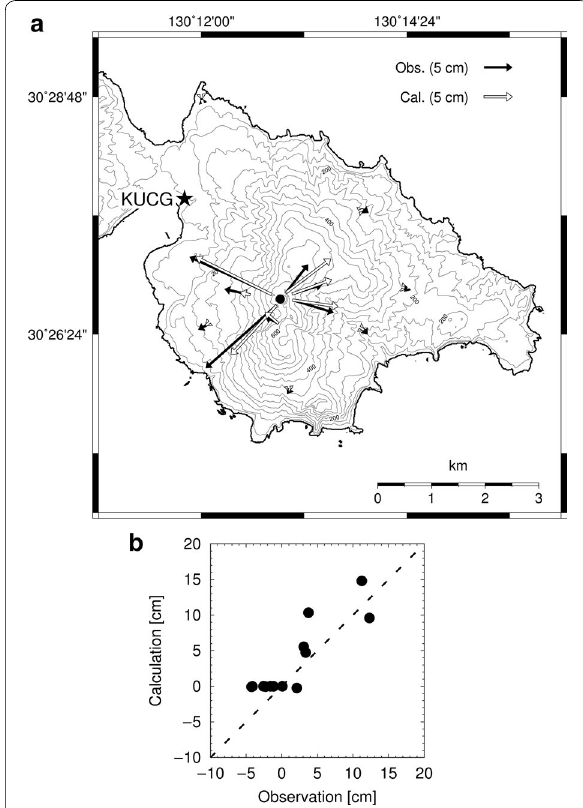
Fig. 7 a Location of obtained deformation source (solid circle) and comparison of observed and calculated relative horizontal displace- ments with respect to KUCG (black and white arrows, respectively). b Comparison of observed and calculated relative vertical displace- ments with respect to